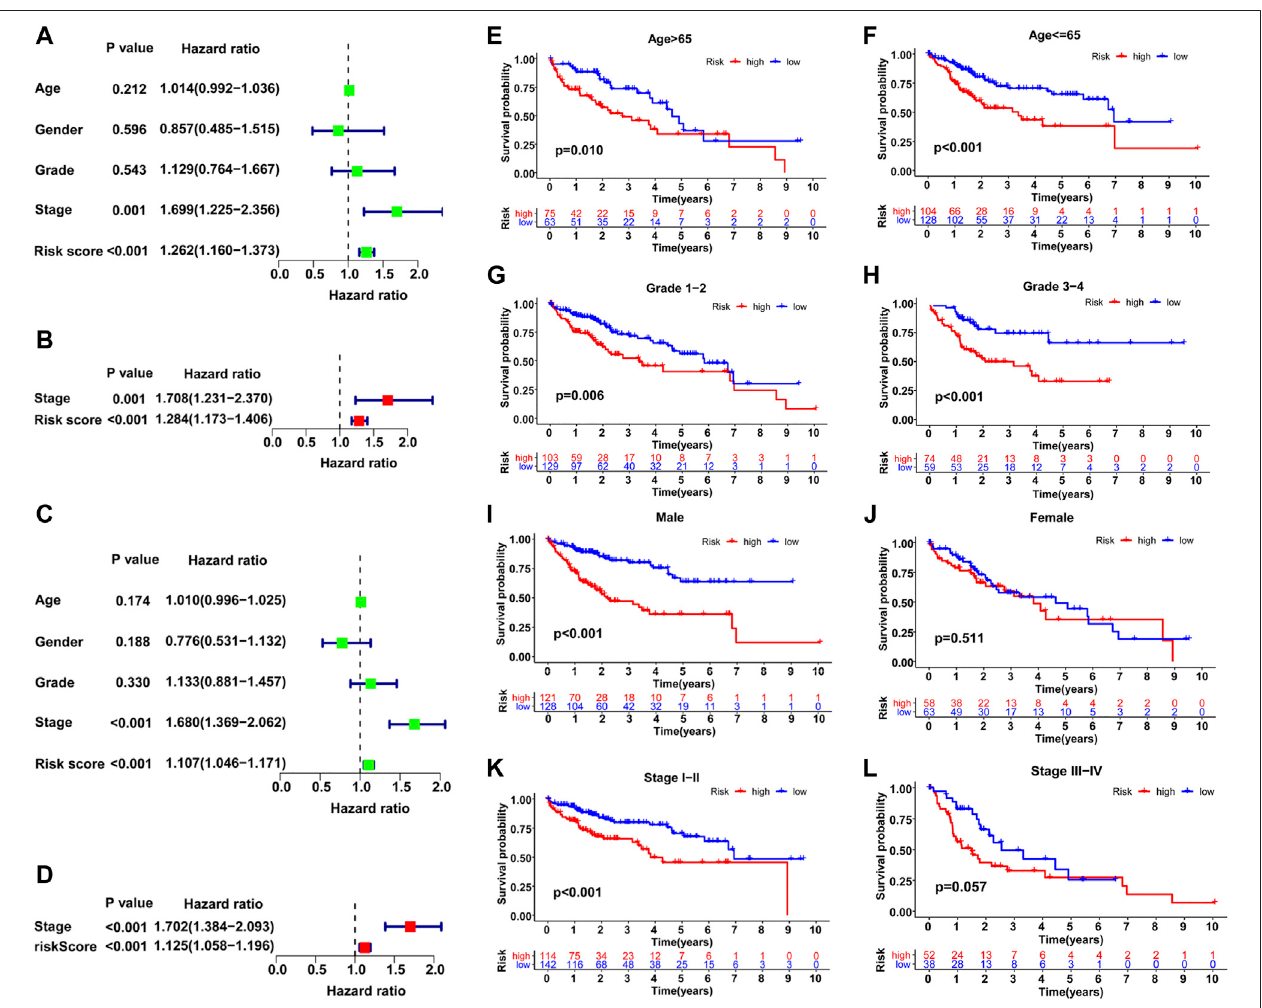
FIGURE 8 | Comparison of the prognostic value of the GILncSig and other clinical variables. Training set (A, B) , TCGA set (C – L) . (A – C) Univariate Cox regression analyses of the OS-related parameters. (B – D) Multivariate Cox regression analysis of the OS-related parameters. Strati fi cation analysis and Kaplan – Meier survival analysisinhigh-riskand low-riskgroupsforoldpatients (E) ,youngpatients (F) ,early-gradepatients (G) ,late-gradepatients (H) ,male (I) ,female (J) ,early-stage patients (K) and late-stage patients (L)